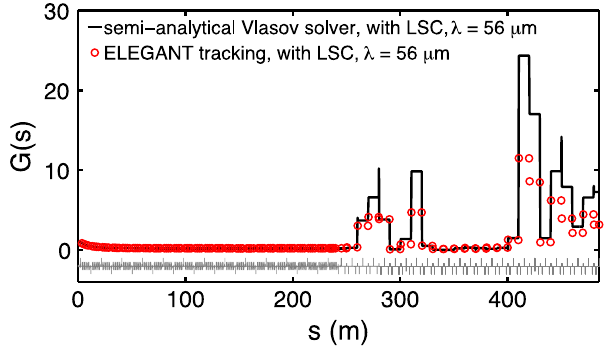
FIG. 5. LSC-induced microbunching gain function G ð s Þ for the linac-arc lattice. Here in ELEGANT tracking we assume 0.1% initial modulation